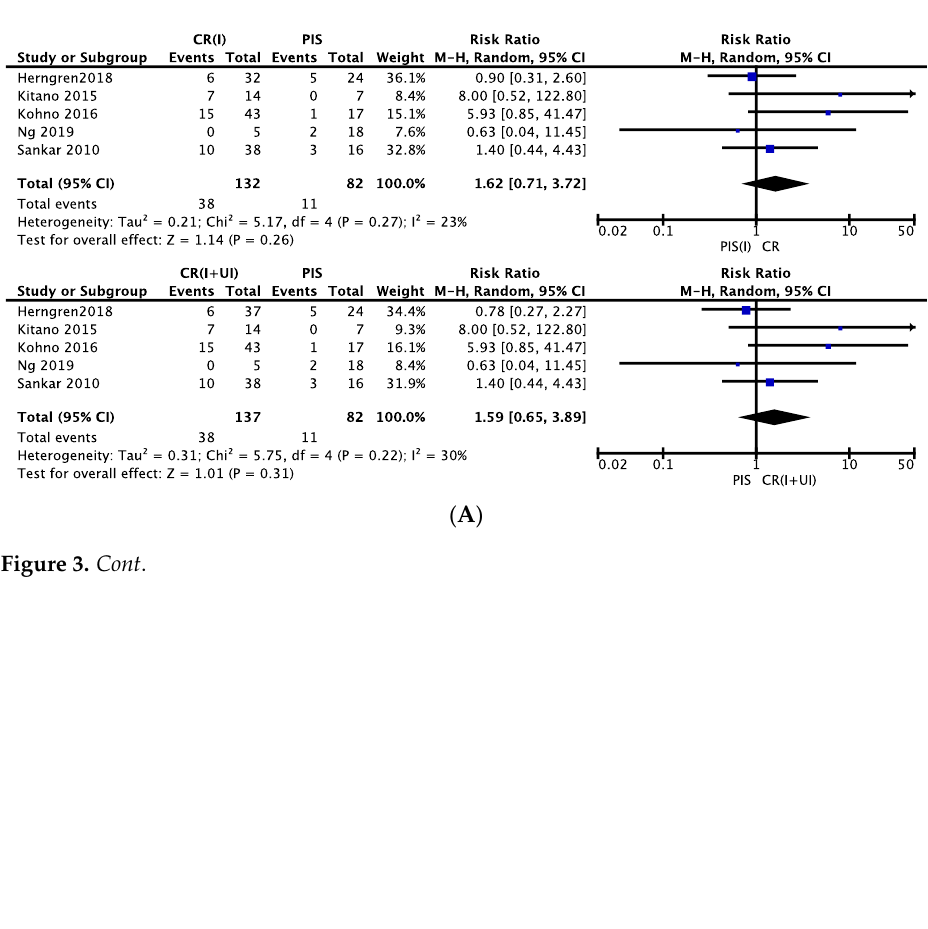
Table 4. Rates of AVN according to severity and method of intervention in closed pinning.